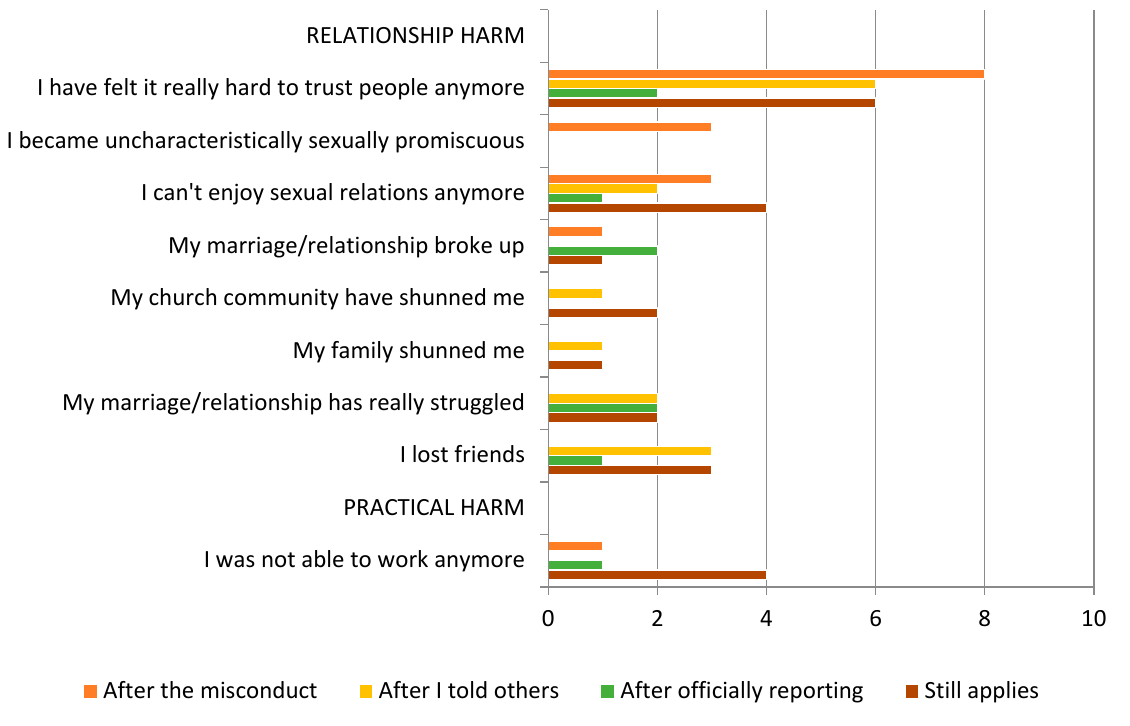
Figure 4. Relational, and practical harms produced by CSMAA according to time periods ( n = 22). More than one response was permitted.